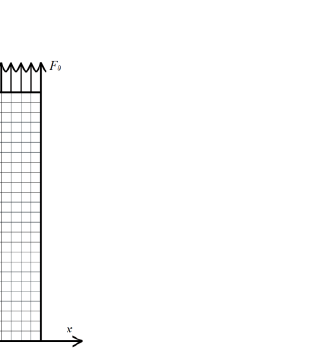
Fig. 1. Finite element meshes and loading